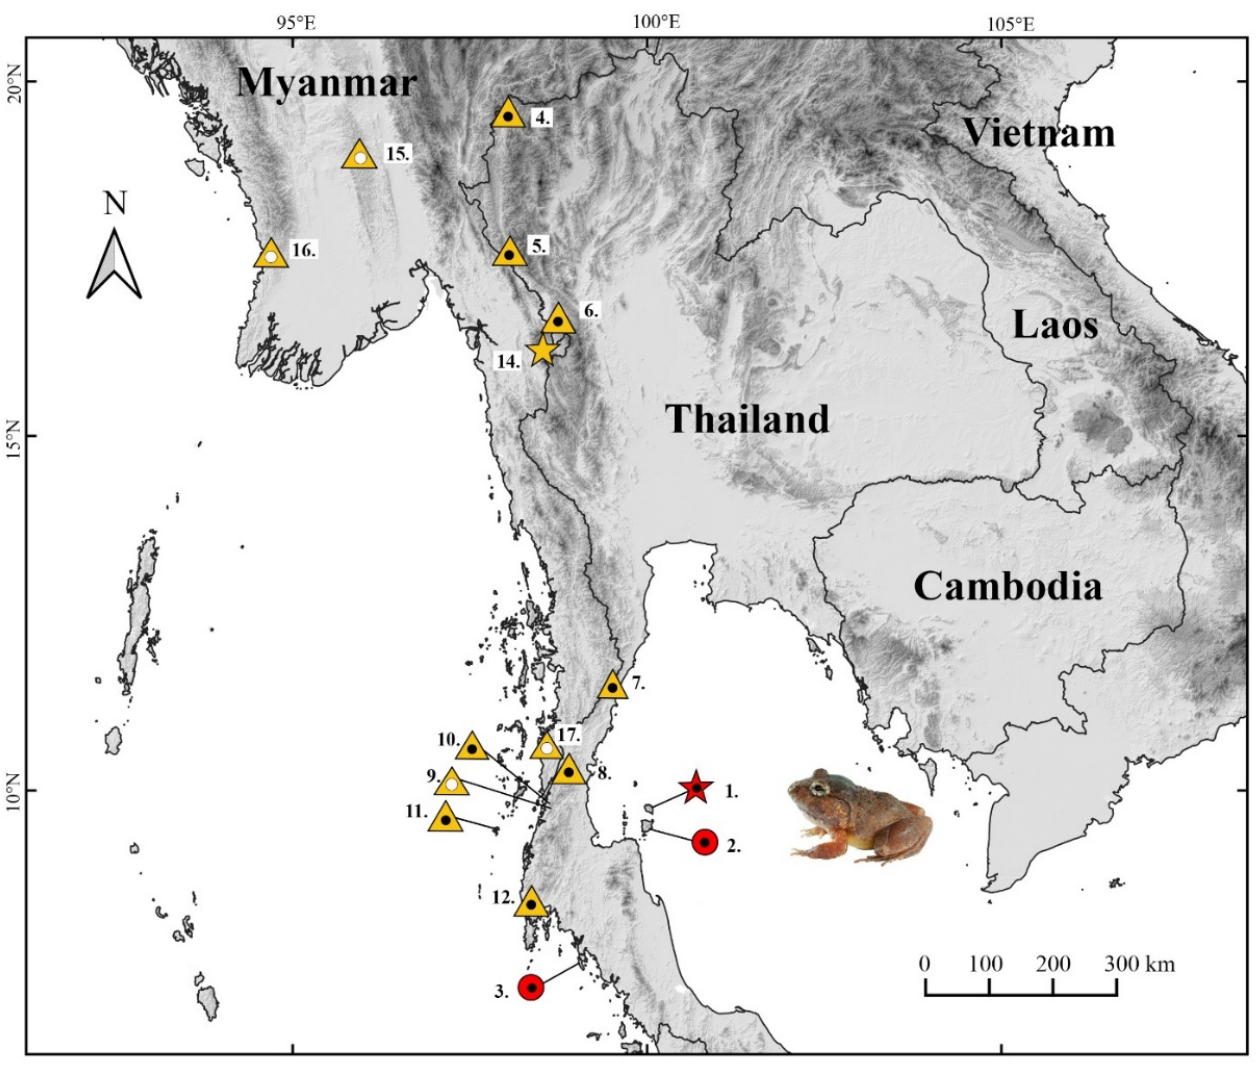
Figure 8. Map showing the type locality (red star) at Ko Pha-ngan Island, Surat Thani Province, Thailand and paratype localities (red circles) at Ko Samui Island, Surat Thani Province and Ko Lanta Yai Island, Krabi Province, Thailand of Limnonectes pseudodoriae sp. nov ., the type locality (yellow star) in Myanmar, and the localities of studied specimens (yellow triangles) of L. doriae in Thailand and Myanmar. Numbers correspond to those in Table S1. Shaded symbols indicate morphological data only, Shaded symbols with white center dot indicate molecular data only, and shaded symbols with black center dots indicate both molecular and morphological data were studied.